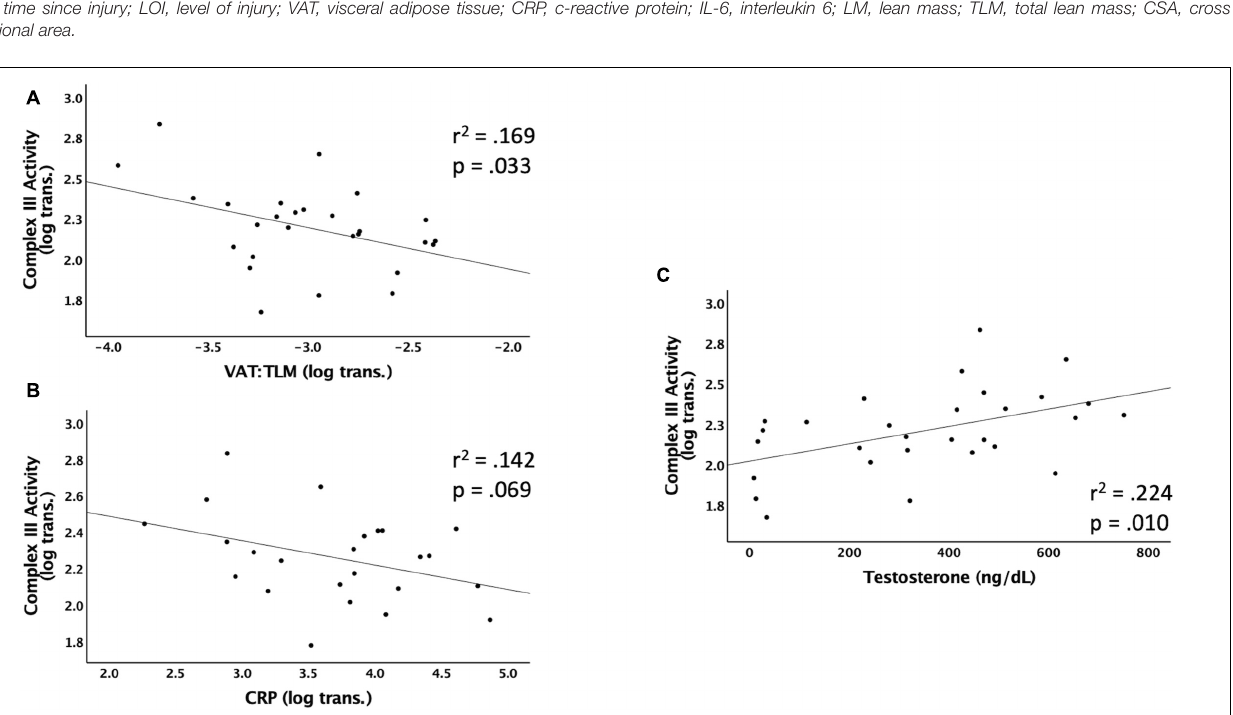
Citrate synthase activity r 2 ( p -value)